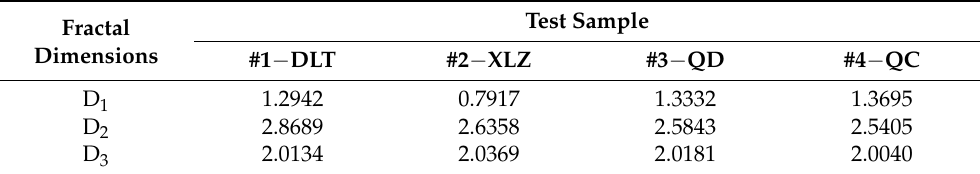
Table 2. The calculation results of fractal dimensions.